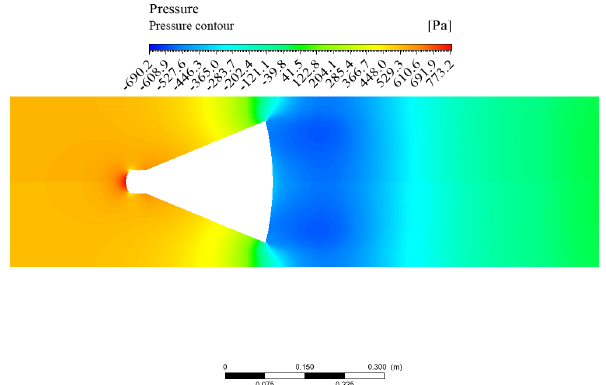
Figure 17. Velocity vector map, proposed flowmeter.